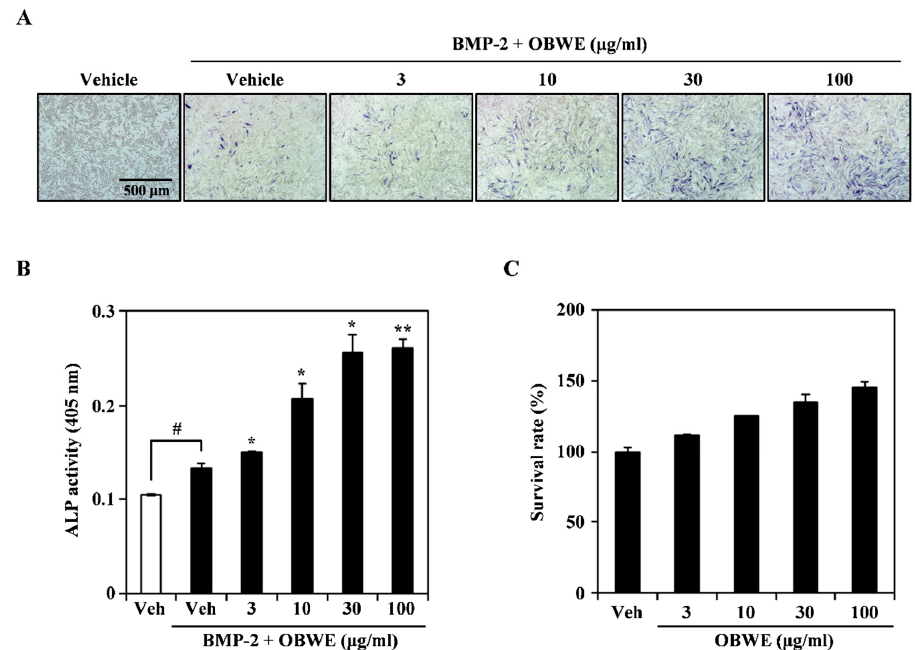
Figure 3. OBWE promotes BMP-2-induced osteoblast differentiation. ( A ) C2C12 cells were